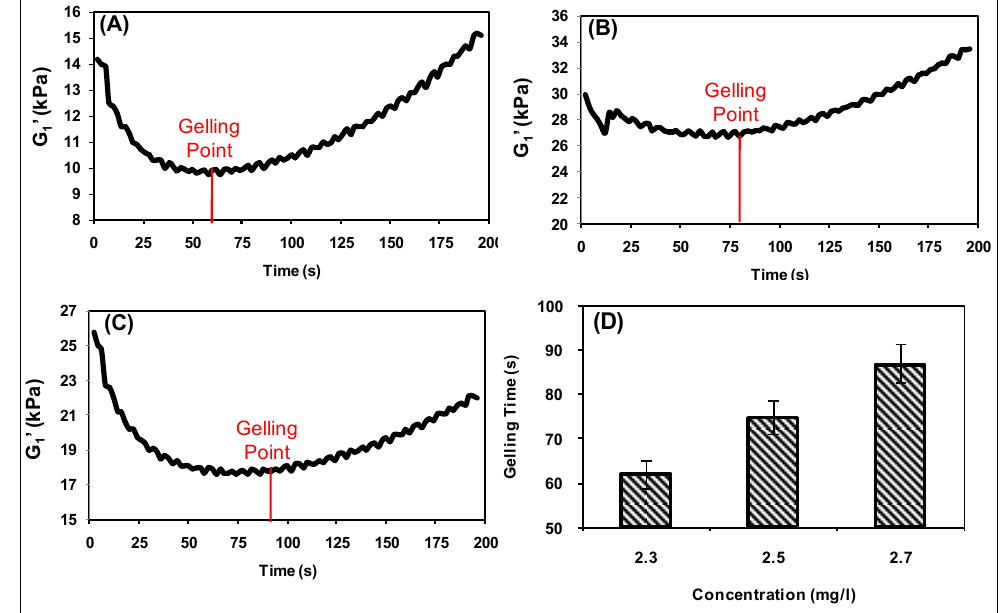
Figure 5. Gelling behaviour of the paste with concentrations of (A) 2.3 g/ml; (B) 2.5 g/ml; and (C) 2.7 g/ml and (D) the effect of paste concentration on the gelling time.